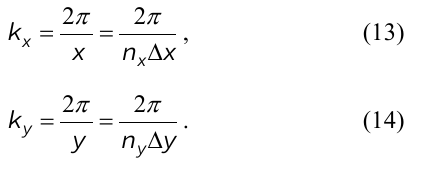
Figure 12: Co mparisons of the electric field components profiles obt ained f rom t he pr oposed t ime-frequency computation method and the direct calculation, detected in the vertical plane placed at y =